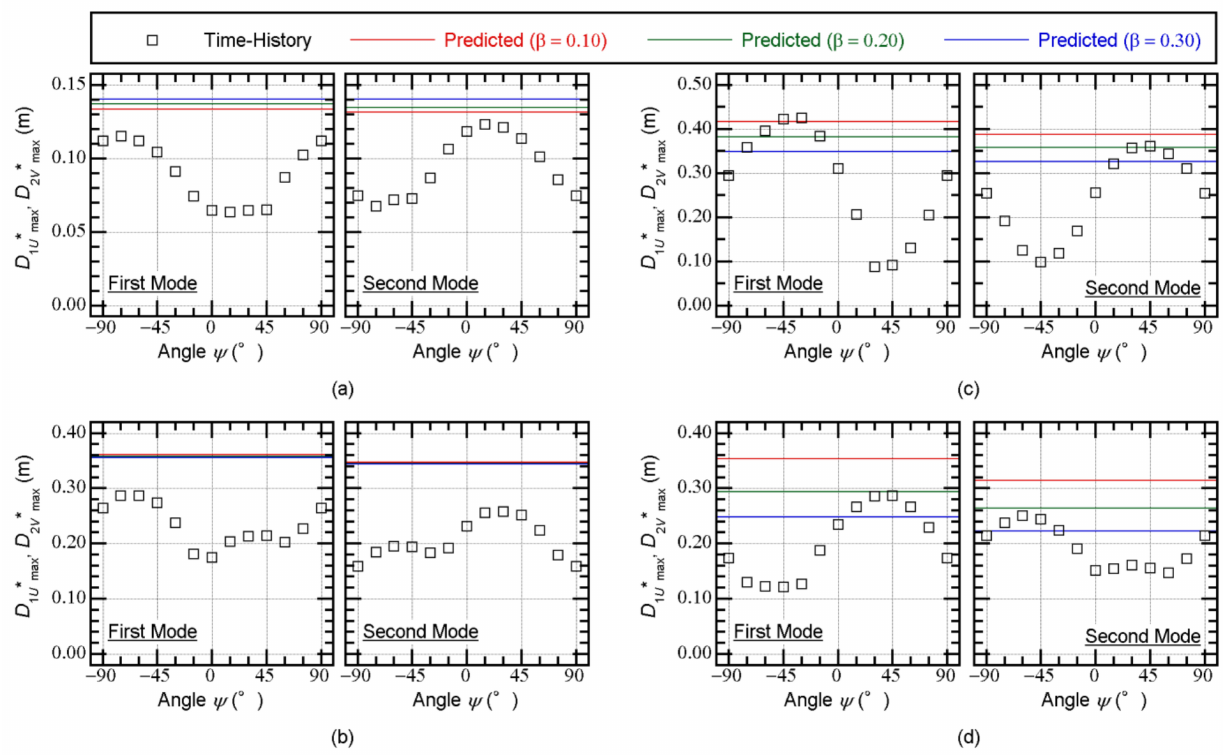
Figure 40. Peak equivalent displacements of the first two modes for various directions of seismic input (Model-Tf44): ( a ) UTO0414; ( b ) UTO0416; ( c ) TCU; ( d )